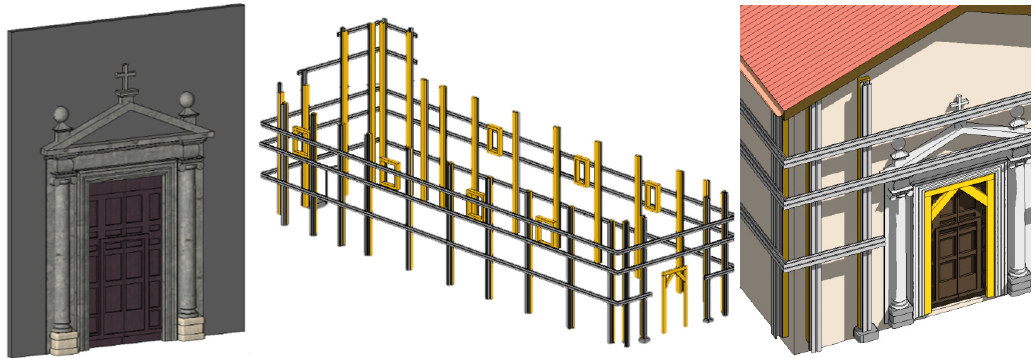
Figure 6. Customized door family and the generic models for the safety structures.